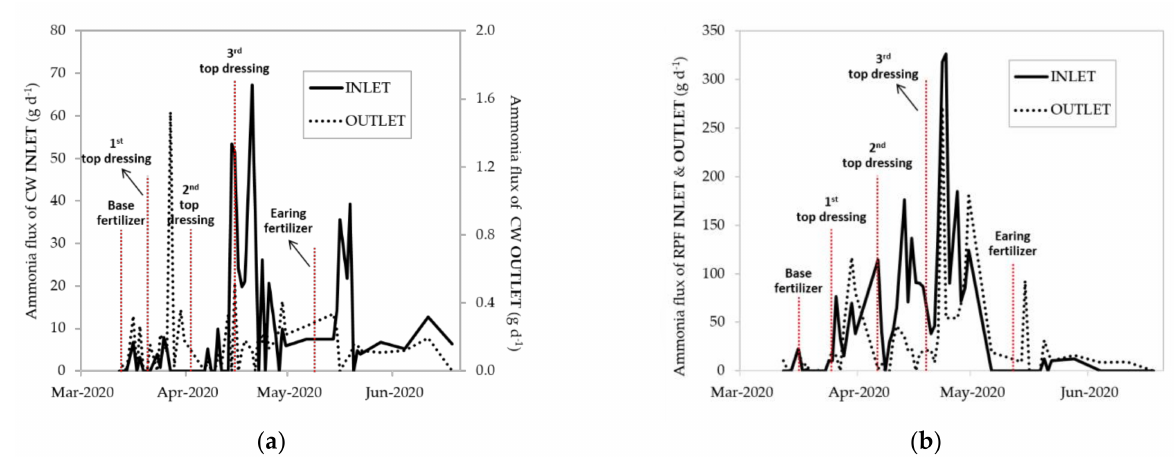
Figure 4. Ammonia fluxes of INLET and OUTLET in ( a ) CW treatment and ( b ) RPF treatment of the first crop season, 2020 (March–June); each fertilization timing is marked. Table 4. The average ammonia fluxes and removal efficiency of each fertilization period. Fertilization